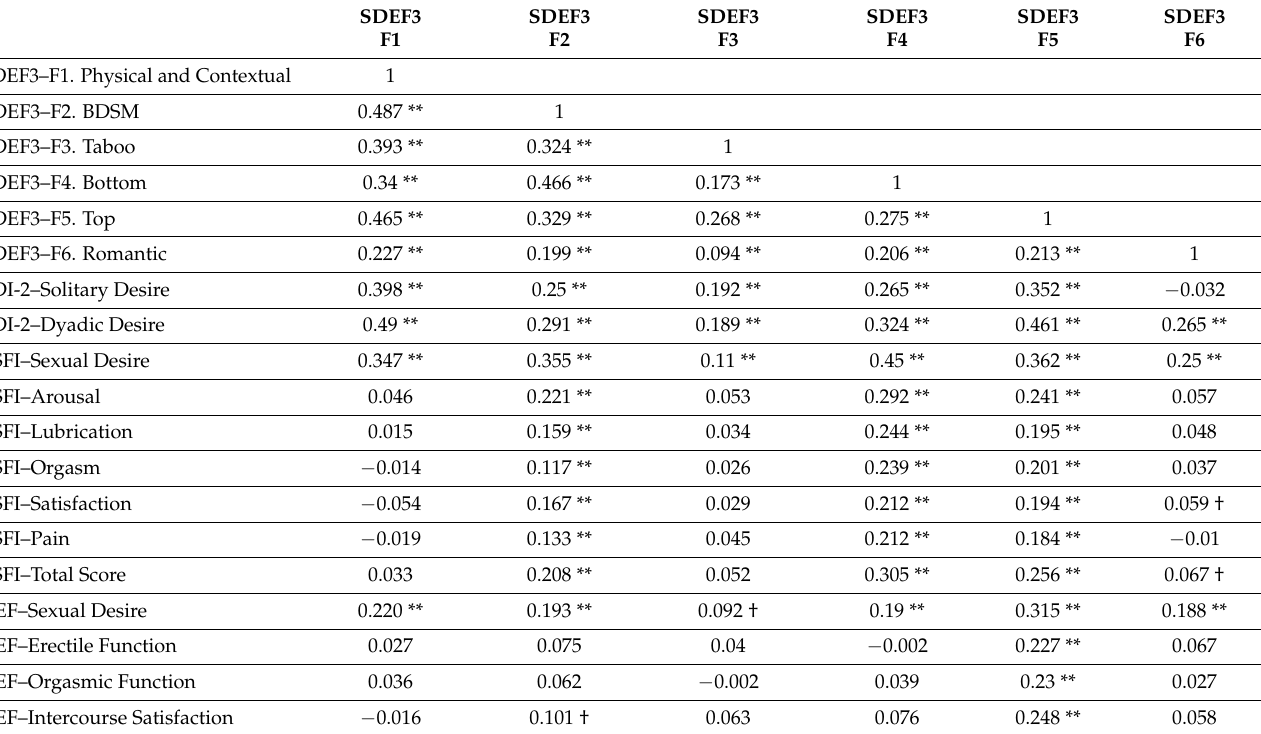
Table 3. Person’s correlation matrix between SDEF3 six-factor solution, SDI-2, FSFI and IIEF ( n =